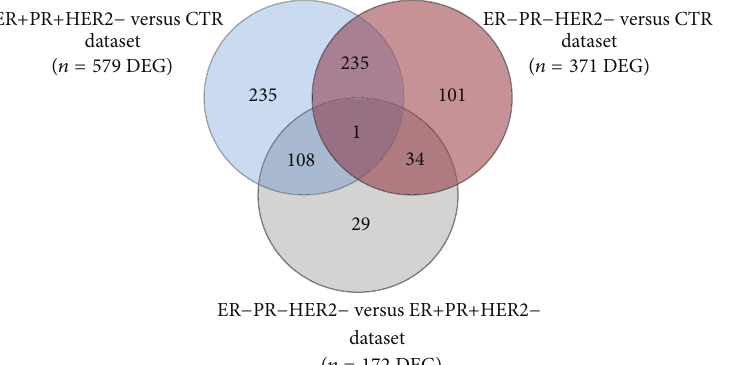
Figure 2: Venn diagram of genes/sequences with differential expression exceeding 1.5-fold in the compared groups. The overlap areas show unique signatures for ER+PR+HER2 − (108) and ER − PR − HER2 − (TNBC) (34) subtypes.